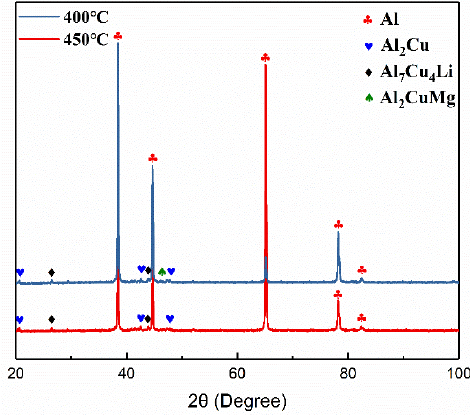
Figure 9. XRD pattern of the sample at 400 °C and 450 °C.